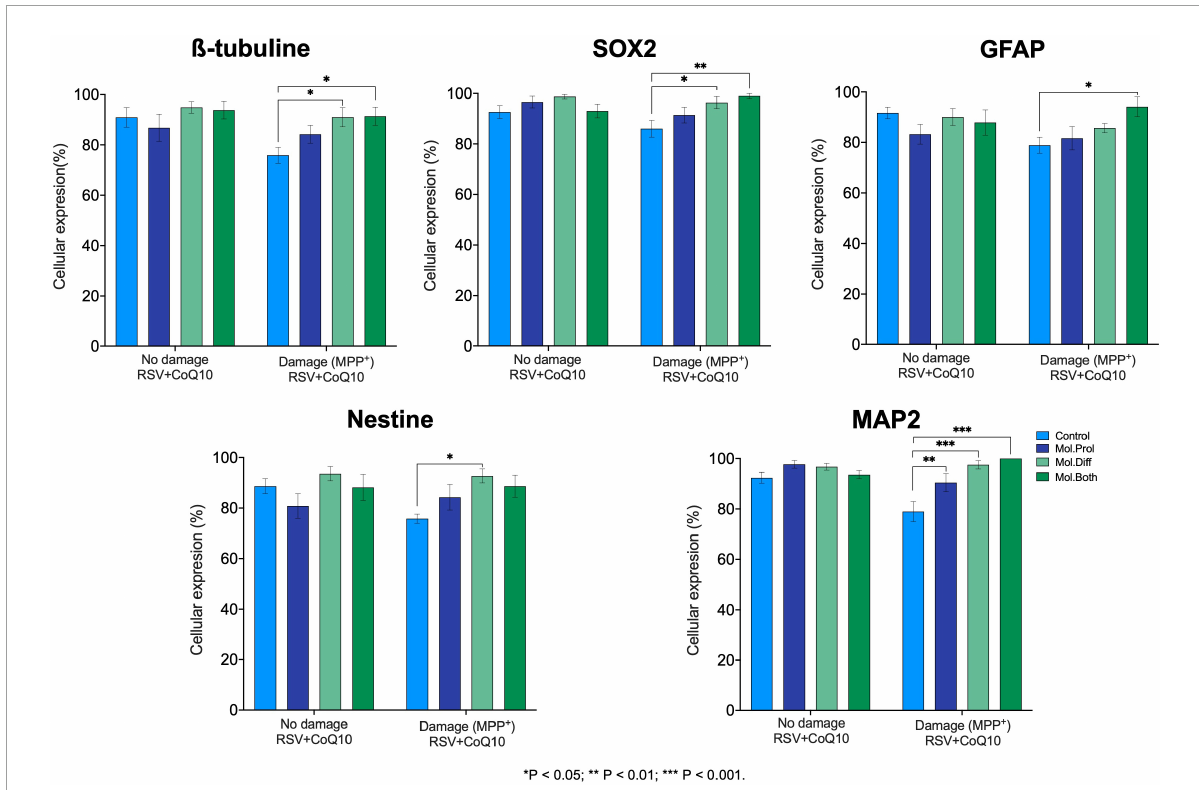
FIGURE6 Cellular expression of neural stem cell (NSC) markers from human mesenchymal stem cells (hMSCs). The application of RSV + CoQ10 did not induce effects on the expression of neural markers when applied to hMSCs without damage; however, when supplemented after the induced damage, it showed a significant recovery effect on the cellular expression of all neural markers. CoQ10, coenzyme Q10; RSV, resveratrol. ∗ P < 0.05; ∗∗ P < 0.01; ∗∗∗ P < 0.001. One-way ANOVA was followed by Dunnett’s